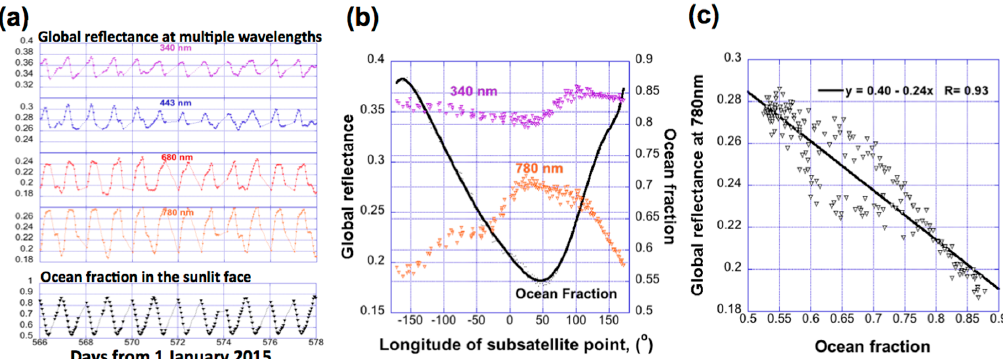
Figure 1. The diurnal variability of global reflectance and its relationship to the ocean fraction over the sunlit face of the Earth from 20 July to 31 July 2016. (Positive longitude means East, negative—West) ( a ) Global reflectance at four wavelengths (340, 443, 680 and 780 nm) and the ocean fraction. ( b ) The ocean fraction and the global reflectance at 340 and 780 nm as a function of the sub-satellite longitude. ( c ) Strong anti-correlation between the 780 nm global reflectance and the ocean fraction. The black straight line is the linear regression fit for the scattered data plot (little triangles) of global reflectance vs. ocean fraction.